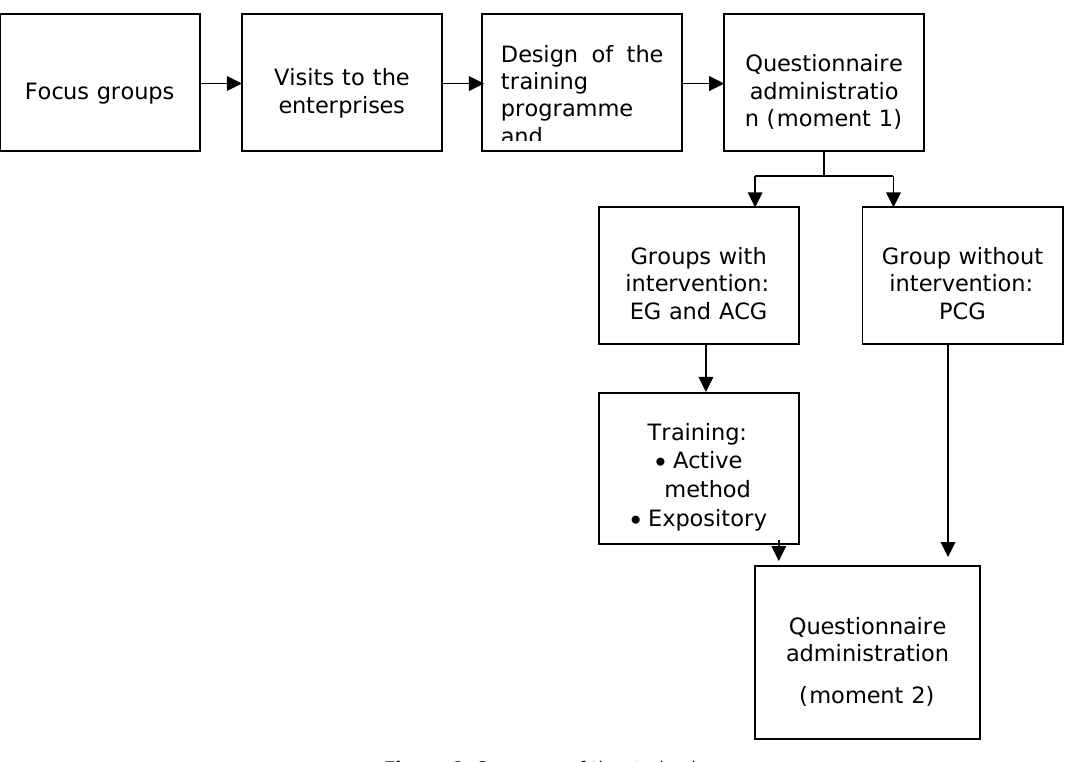
Figure 1 . Summary of the study